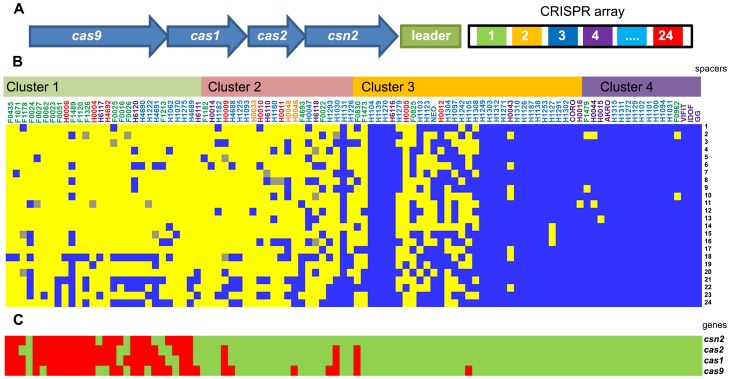
CRISPR spacer oligotyping and CRISPR-associated protein diversity in L. rhamnosus species.Panel (A) illustrates the genetic organization of the CRISPR system and its associated genes in L. rhamnosus GG. Panel (B) shows the conservation (blue), the partial conservation (grey) or the absence (yellow) of L. rhamnosus GG spacers. The presence (green) or the absence (red) of the cas genes is also indicated in Panel (C). Strains are organized according to their genetic relatedness defined in Figure 1.